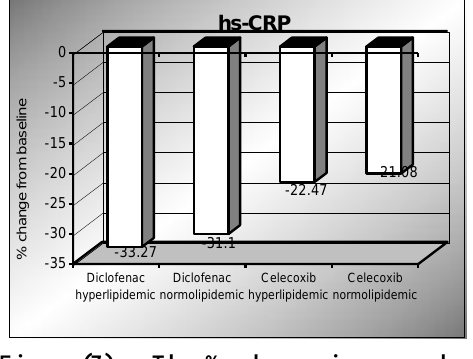
Figure (7): - The % change in serum hs- CRP concentration from baseline value after 8 weeks treatment with diclofenac or celecoxib in hyperlipidemic